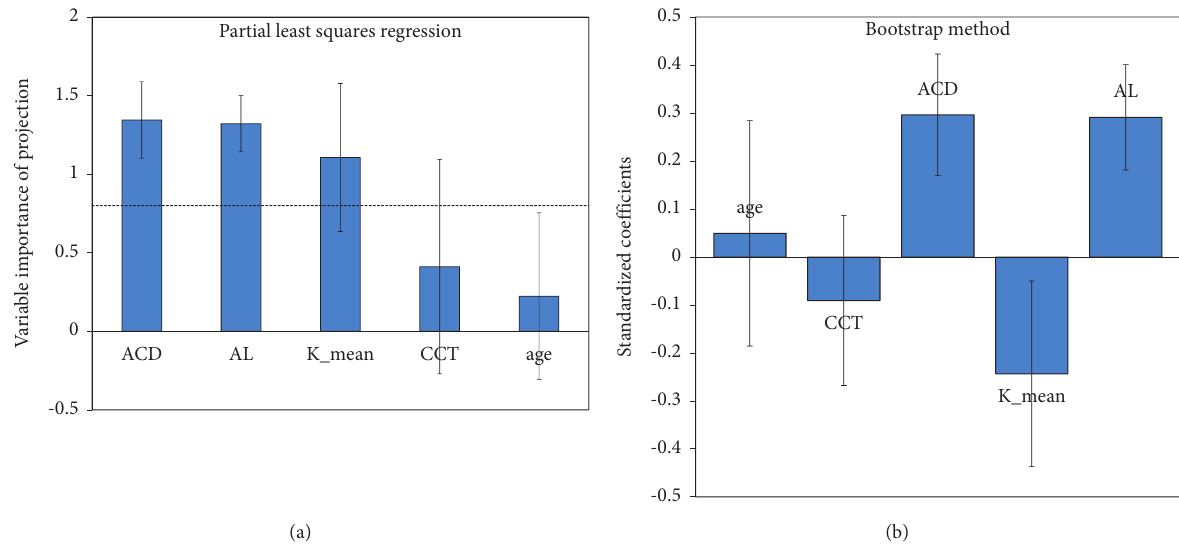
Figure 3: Partial least squares regression model and bootstrap model to predict the pilocarpine-induced ACD shift using AL (axial eye length in mm), Kmean (mean keratometry in diopters), CCT (central corneal thickness in µ m), and ACD (baseline anterior chamber depth in mm).